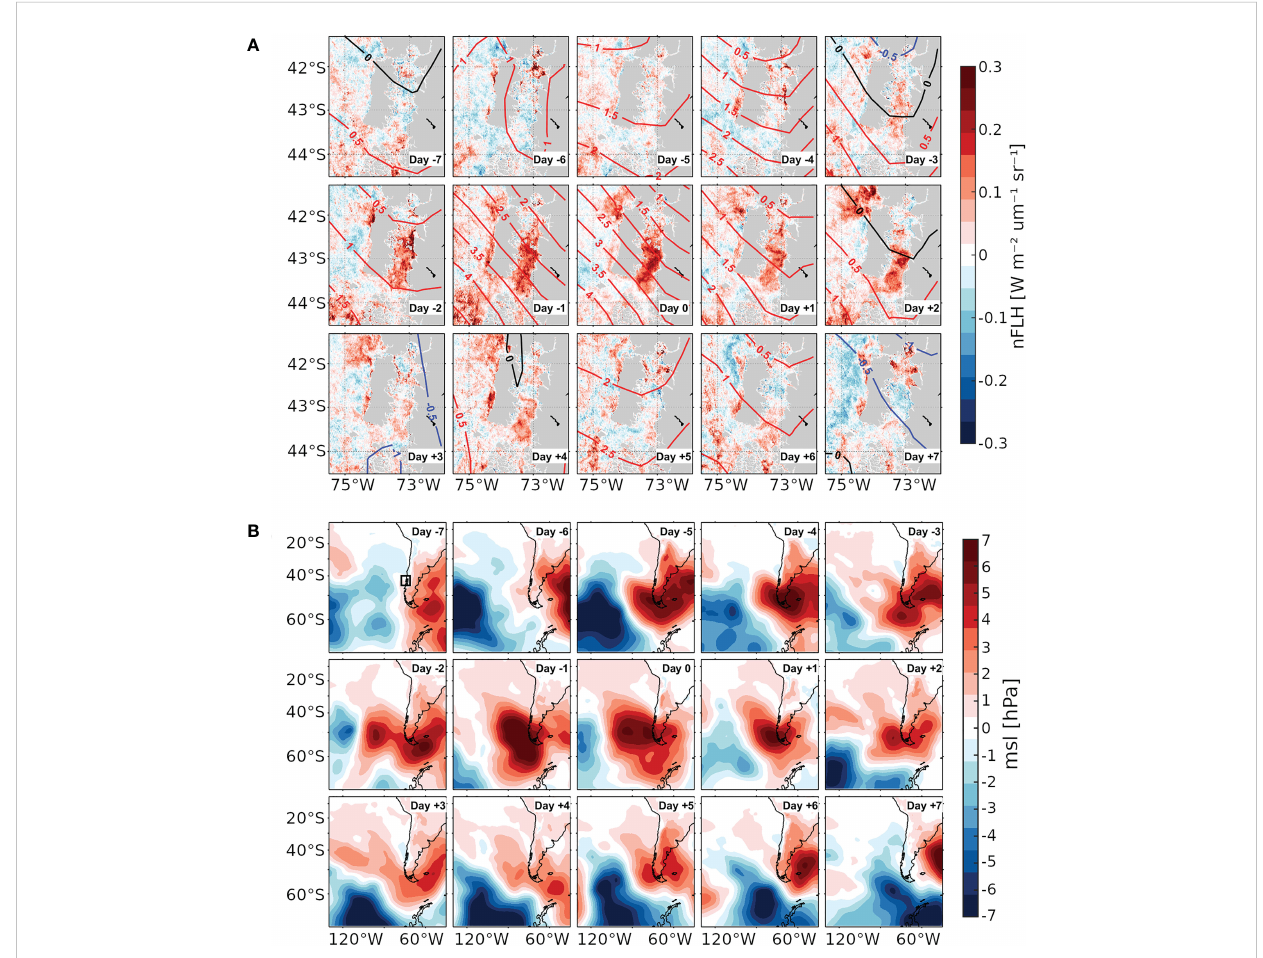
FIGURE 2 (A) Composites of nFLH ’ (shaded, see colour scale [W m -2 µm -1 sr -1 ]) and MSLP ’ (contours every 0.5 hPa, blue/red for negative/positive anomalies) computed for a sequence of days around the 16 HBEs. The sequence is centred on the HBE onset, i.e., on day 0, and spans from day -7 to day +7. (B) MSLP ’ fi elds as in a) (shaded, see colour scale), but extended to a larger-scale covering the southeast Paci fi c ocean. The box in the upper-left panel indicates the area covered by panel A